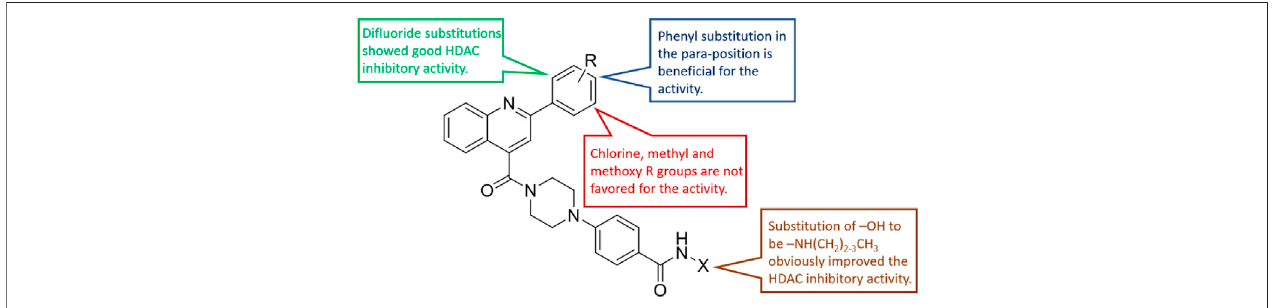
FIGURE 2 | SAR analysis of the derived compounds based on the HDAC enzyme inhibitory results.